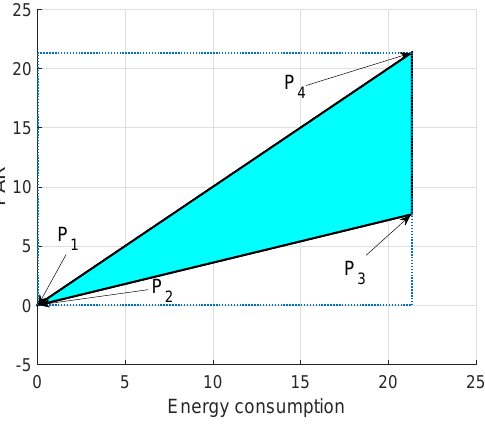
Figure 19. Feasible region for energy consumption and PAR using E2EVHR.